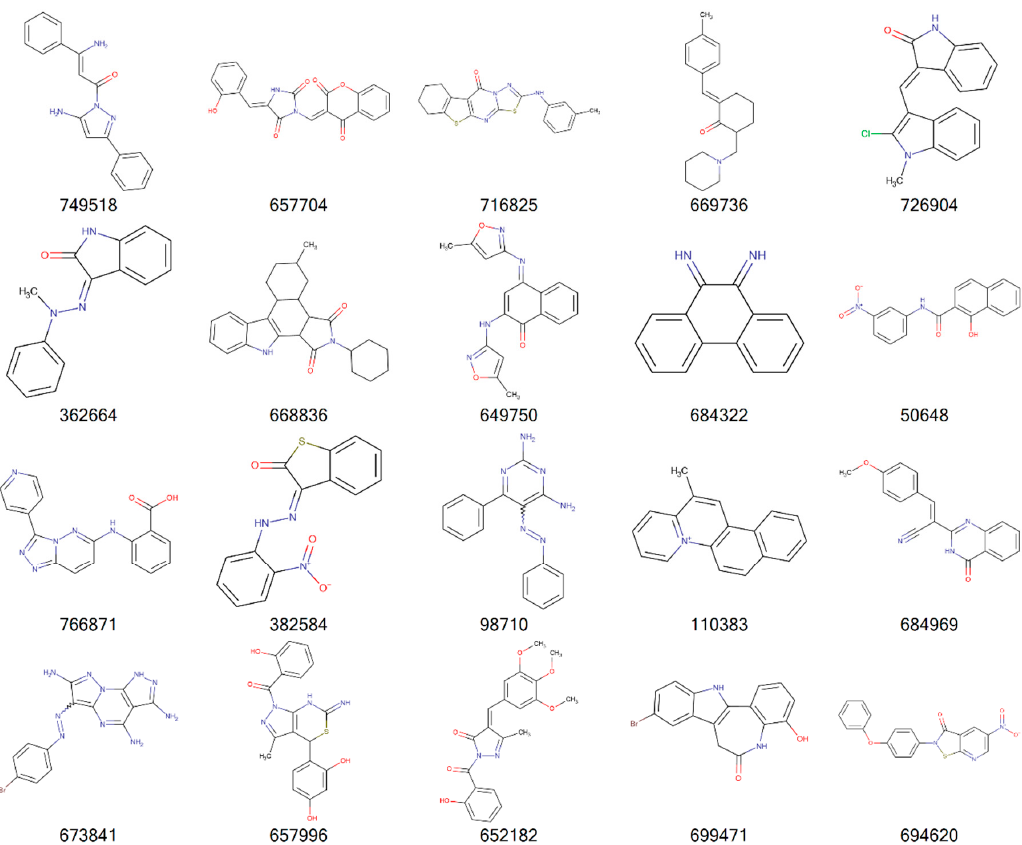
Figure 3. 2D structures of top 20 drug-like ligands for breast cancer. Listed are NSC-749518, NSC-657704, NSC-716825, NSC-669736, NSC-726904, NSC-362664, NSC-668836, NSC-649750, NSC-684322, NSC-50648, NSC-766871, NSC-382584, NSC-98710, NSC-110383, NSC-684969, NSC-673841, NSC-657996, NSC-652182, NSC-699471, and NSC-694620.